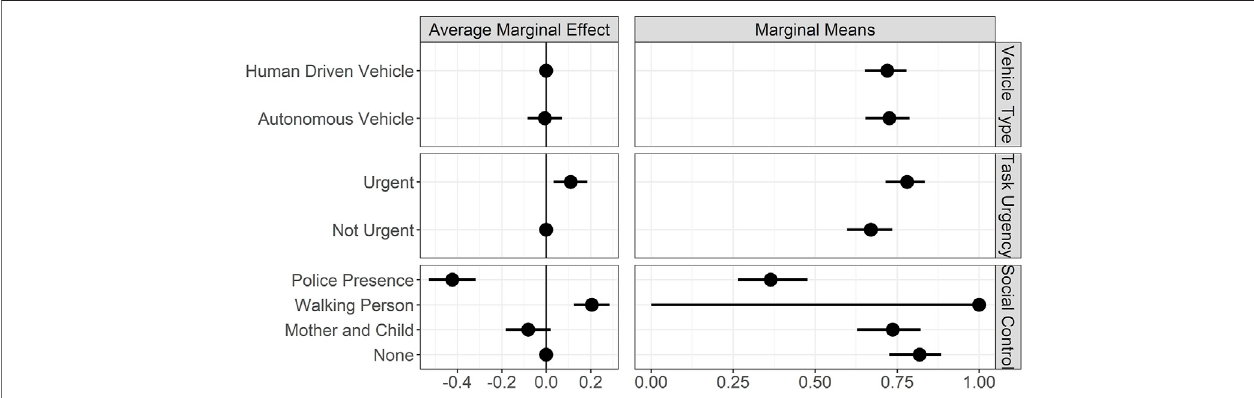
FIGURE 7 | Average marginal effects and marginal means for risk-controlled crossings. Note: left plot shows the average marginal effects (AME) of our three experimental factors in reference to their baseline factor levels. The vertical line represents the effect of the reference level. The right column reports the marginal means (MM)forthedifferentfactorlevelsoncrossingprobabilities,holdingtheotherfactorsconstantattheirproportions.PointsindicateAME/MM,horizontallinesthe95%CIs. Effects based on results of GLMM.